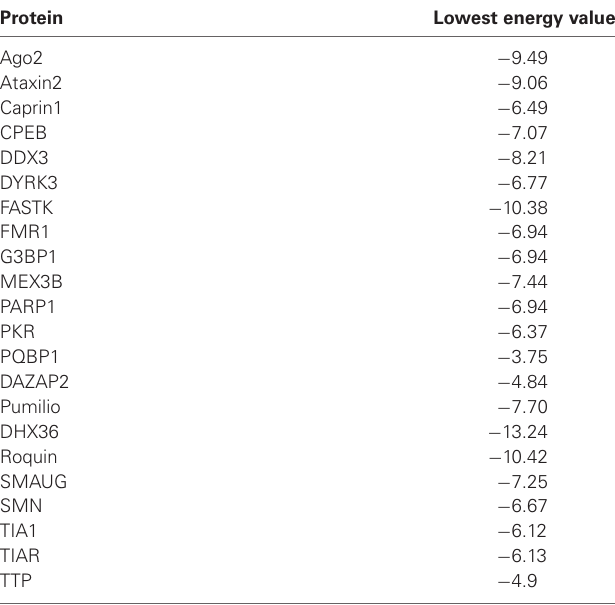
Table 2 | Amyloidogenic propensity of SG nucleating proteins (adapted from Kedersha et al., 2013) calculated by the